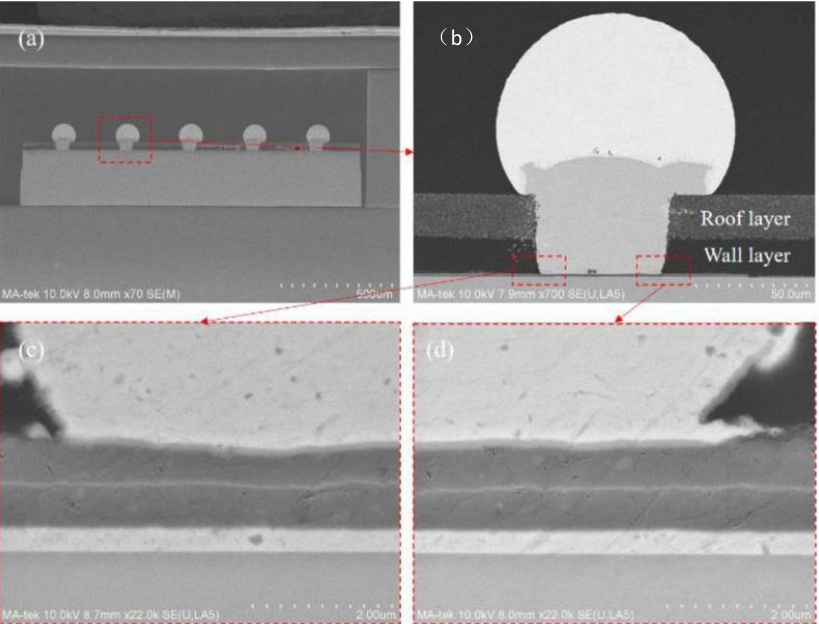
Figure 15. SEM image of the RDL of a single package after uHAST 96 h. ( a ) Cross-sectional picture of the SAW Device WLP with solder ball. ( b ) Interconnection structure of the chip’s pad and the solder ball by TFV. ( c , d ) indicate the interconnection structure on the left and right side of the chip’s pad,